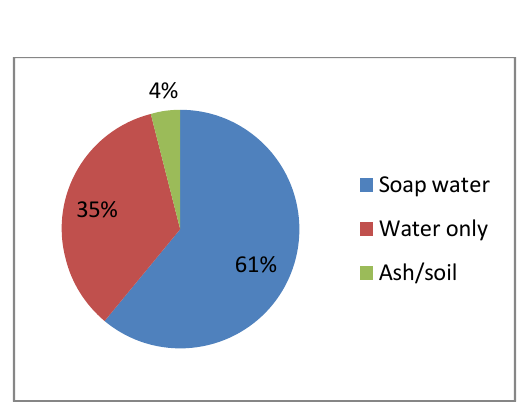
Fig. 1: Hand washing practice of the Respondents Ss